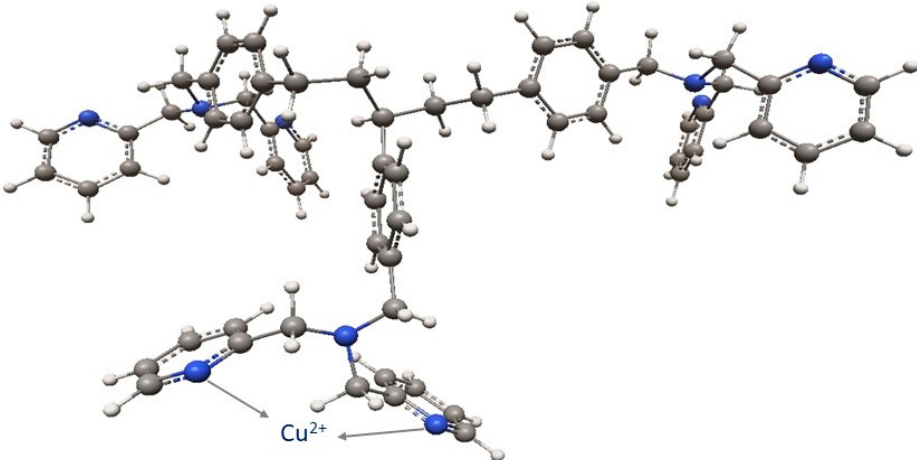
Figure 10. Cu(II) ions complexation by Dowex M 4195 proposed on the basis of theoretical calcula- tions with the bis-(2-pyridylmethyl)amino groups attached in the para position.